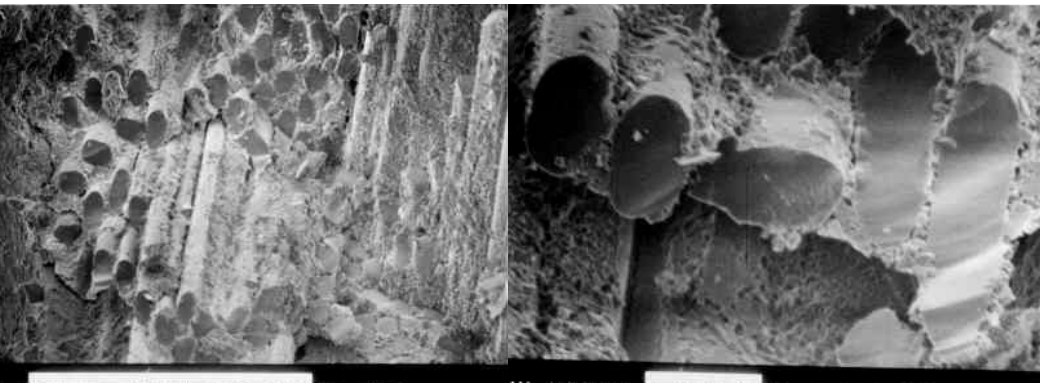
Figure 8. SEM Fracture Surface: Uncoated fiber surfaces tested after 250 °C postcure.